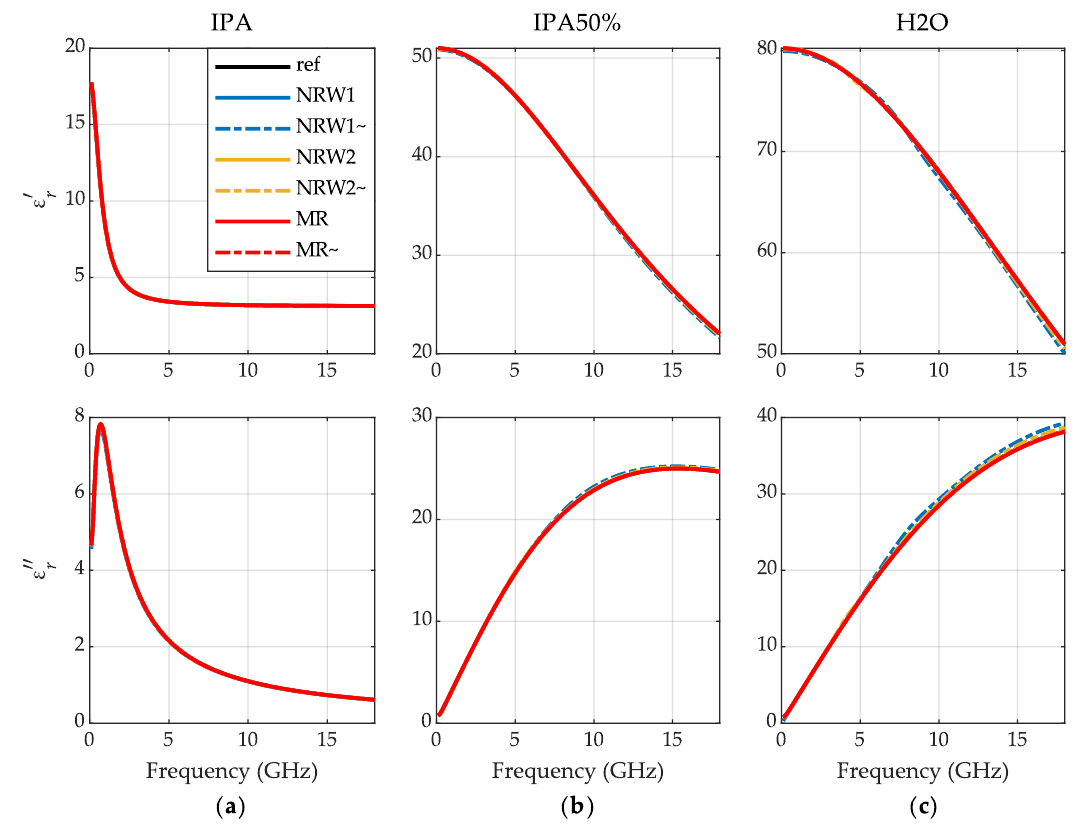
Figure 6. Characteristics of the real ( ε (cid:48) r ) and imaginary part ( ε (cid:48)(cid:48) r ) of permittivity for ( a ) IPA, ( b ) 50% aqueous solution of IPA, ( c ) distilled water. Determined from 0.1 to 18 GHz. Line types: solid—the ideal sample with the flat surface, dashed-dotted— the sample with the meniscus (denoted by ~). Line colors: black—reference, red—the outcome of the meniscus removal (MR) method, blue and yellow—the NRW method for the initial and the final volumes of liquid,